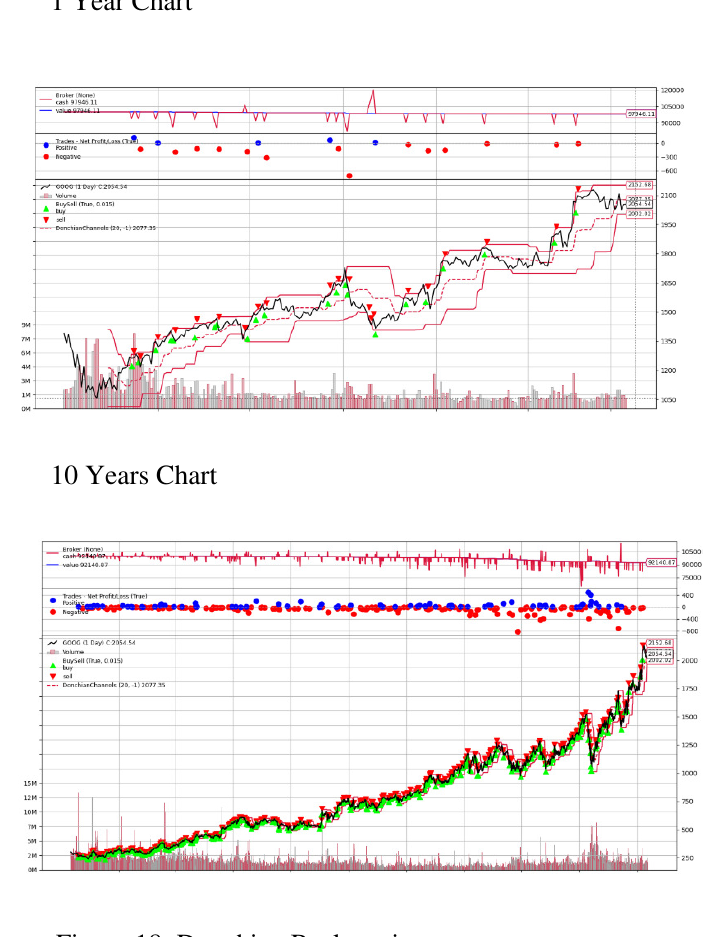
5. Back testing Multiple (cid:23)(cid:14)(cid:13)(cid:14)(cid:24)(cid:7)(cid:10) strategy !